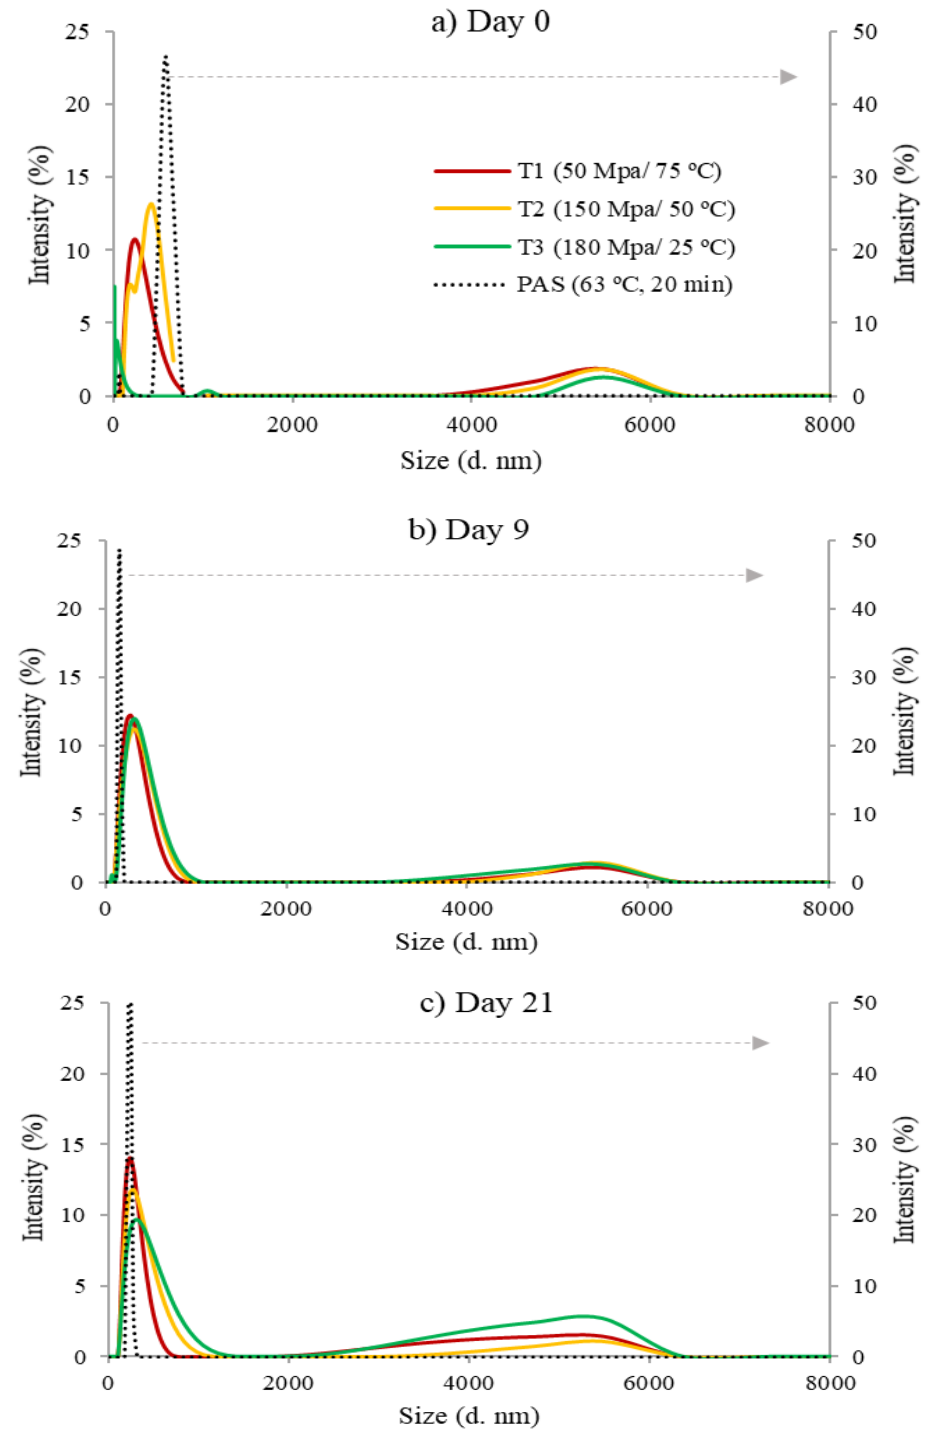
Figure 4. Particle size distribution of Brazil nut beverage treated with HPH and pasteurized and analyzed at ( a ) day 0, ( b ) day 9, and ( c ) day 21 of cold storage.